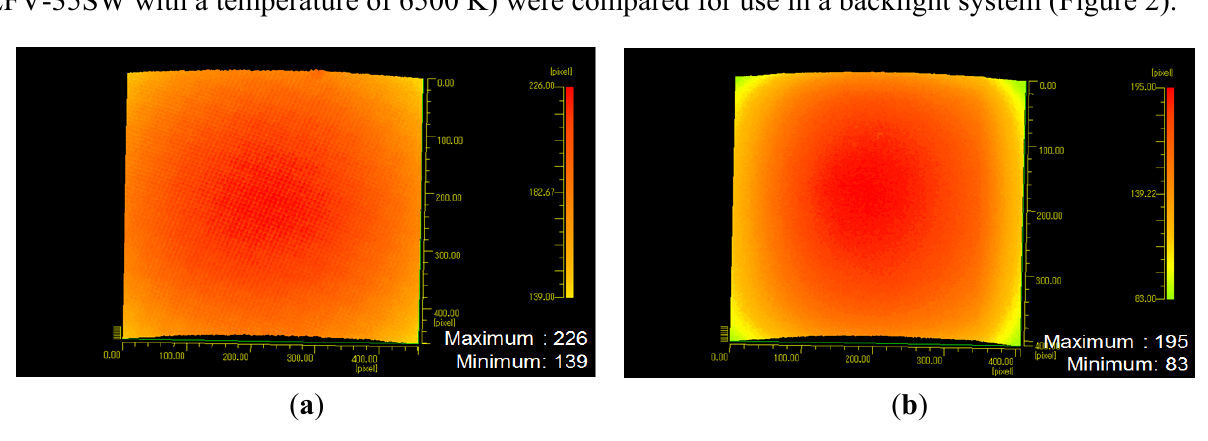
Figure 2. Brightness distribution by using whiteboard for different types of lighting system. ( a ) Flat dome light; ( b ) Coaxial light.